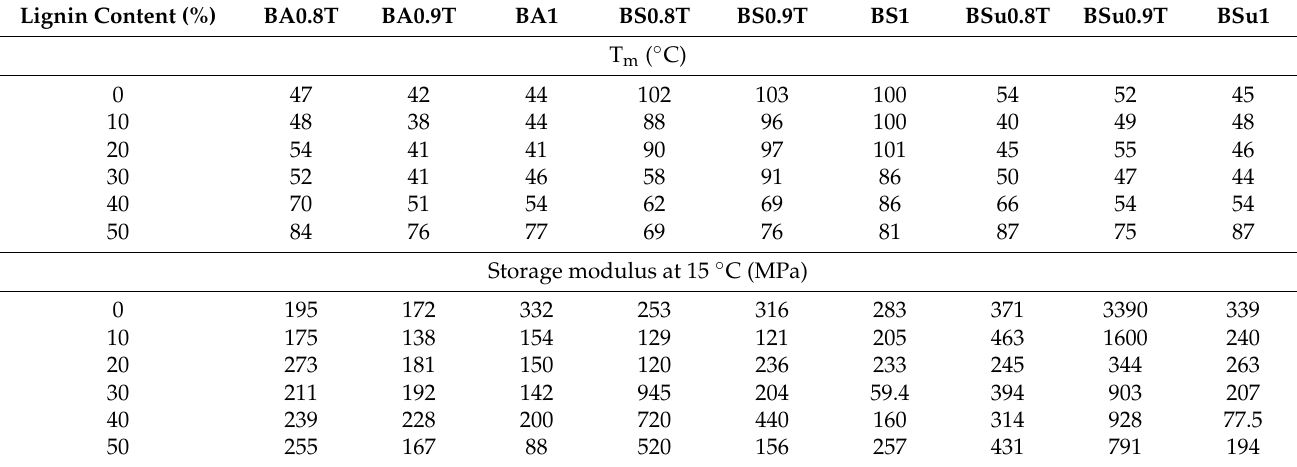
The thermal stability of the lignin-copolyester/amides were determined by thermo- gravimetric analysis (TGA) and differential thermal gravimetry (DTG). Table 6 summarizes the 1st major degradation T onset and the T d5 values of the various lignin-copolyester/amides. The T d5 values were generally lower than the major T onset values. The TGA and DTG thermograms for BA0.8T-lignin copolymer series and kraft lignin are shown in Figure 7. Lignin degradation was shown to occur in 3 stages. The first temperature onset (T onset